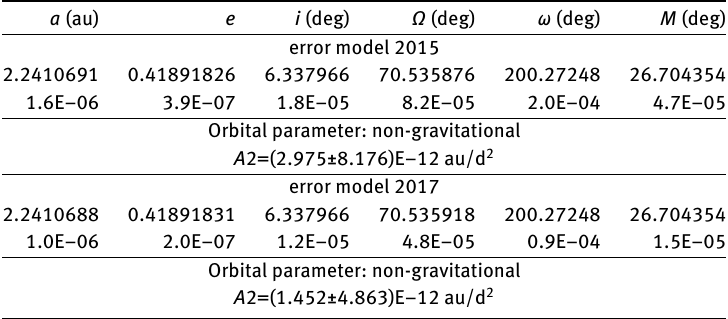
Table 5. Initial nominal orbital elements of the asteroid 2008 LX16 with different error models: a denotes semimajor axis, e - eccentric- ity, angles i , Ω and ω refer to the Equinox J2000.0, M - mean anomaly. Epoch JD2458400.5 TDB = 9 October 2018. Orbital elements are computed with the non-gravitational parameter A 2. a (au) e i (deg) Ω (deg) ω (deg) M